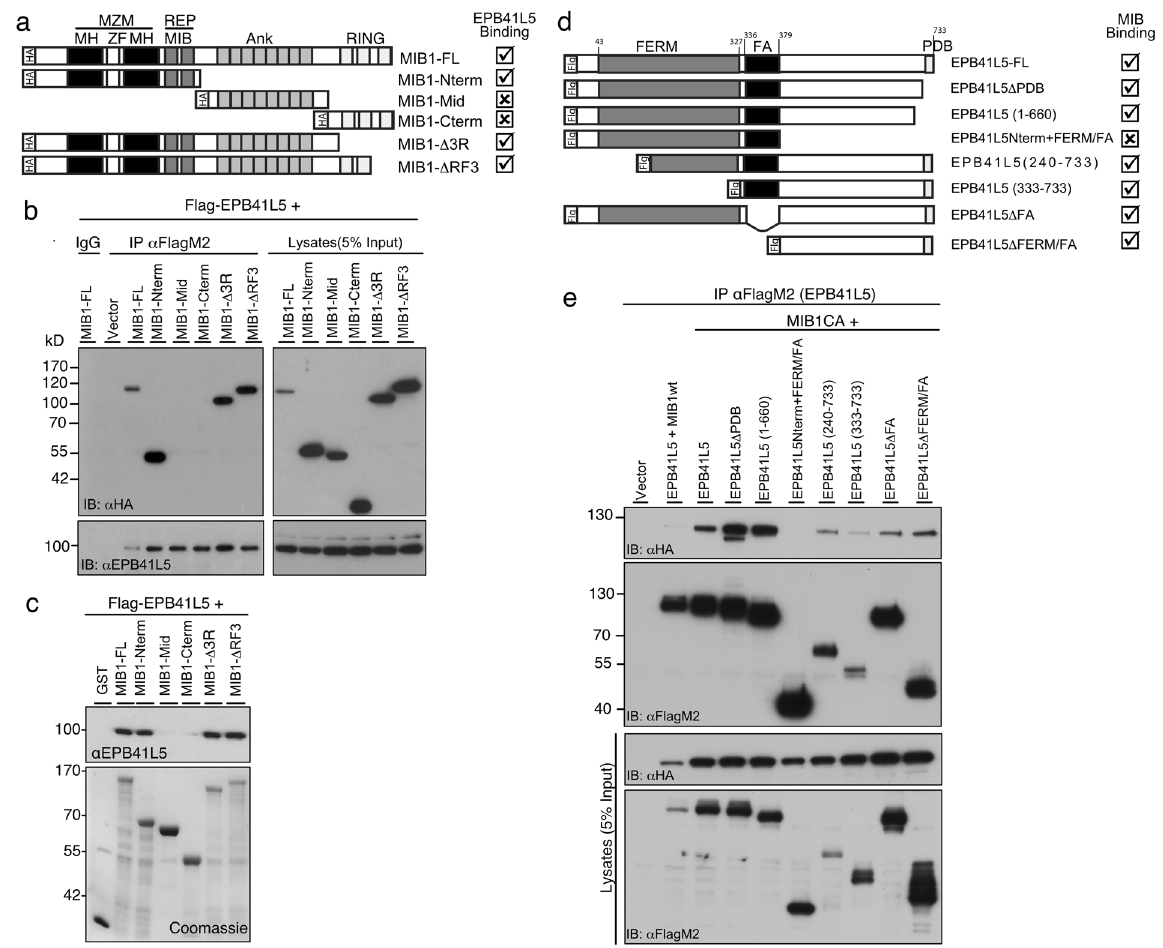
Figure 6. MIB1 MZM/REP region is required for binding to EPB41L5. ( a ) Schematic of the MIB full length (FL) and truncation mutant proteins displaying various domains as follows: MZM [MIB/HERC2 domains (MH); Zinc finger (ZF)]; REP [MIB domain (MIB)]; Ankyrin repeats (Ank); RING fingers; HA, Hemagglutinin tag. MIB1-FL and truncated mutants were used to map the interaction site of MIB1 with EPB41L5 by co- immunoprecipitation experiments. ( b ) The N-terminus of MIB1 mediates association with EPB41L5. Co- immunoprecipitation experiments were performed on lysates from HEK293T cells co-transfected with FLAG- EPB41L5 and the indicated HA-tagged MIB1 mutant. EPB41L5 co-immunoprecipitates MIB1-FL, MIB1- Nterm, MIB1- ∆ 3R and MIB1- ∆ RF3. The panel on the right shows the relative expression of EPB41L5 and MIB1 constructs respectively, in whole cell lysates. ( c ) EPB41L5 binds to FL and N-terminus of recombinant GST-tagged MIB1. GST pulldown experiments were performed using GST-tagged MIB1-FL and mutants as described in ( a ), with lysates prepared from HEK293T cells transiently transfected with Flag-EPB41L5. EPB41L5 bound to GST-fusion proteins was identified by immunoblotting with anti-EPB41L5. The amount of GST-fusion protein used is shown in the coomassie-stained blot. ( d ) Schematic representation of the EPB41L5 full length (FL) and truncation mutant proteins displaying the FERM domain and PDZ-binding motif (PDB). ( e ) EPB41L5 co-immunoprecipitates MIB1 and the N-term + FA region of EPB41L5 is not required to mediate this interaction. Co-immunoprecipitation experiments were performed on lysates from HEK293T cells co- transfected with the FLAG-EPB41L5-FL or truncation mutants, and HA-MIB1 CA RING mutant (MIB1CA). The MIB1CA mutant binds EPB41L5, and was used in these experiments because, unlike MIB1WT, it is not degraded. Anti-FlagM2 immunoprecipitates were immunoblotted for bound MIB1 using anti-HA (top panel). All EPB41L5 deletion mutants except that lacking the C-terminus (EPB41L5Nterm + FERM/FA) bound MIB1CA. The lower panels show the relative expression of Flag-EPB41L5 and HA-MIB1 constructs, in whole cell lysates. For clarity, some blots were cropped. The full length blots are shown in Supplementary Fig.